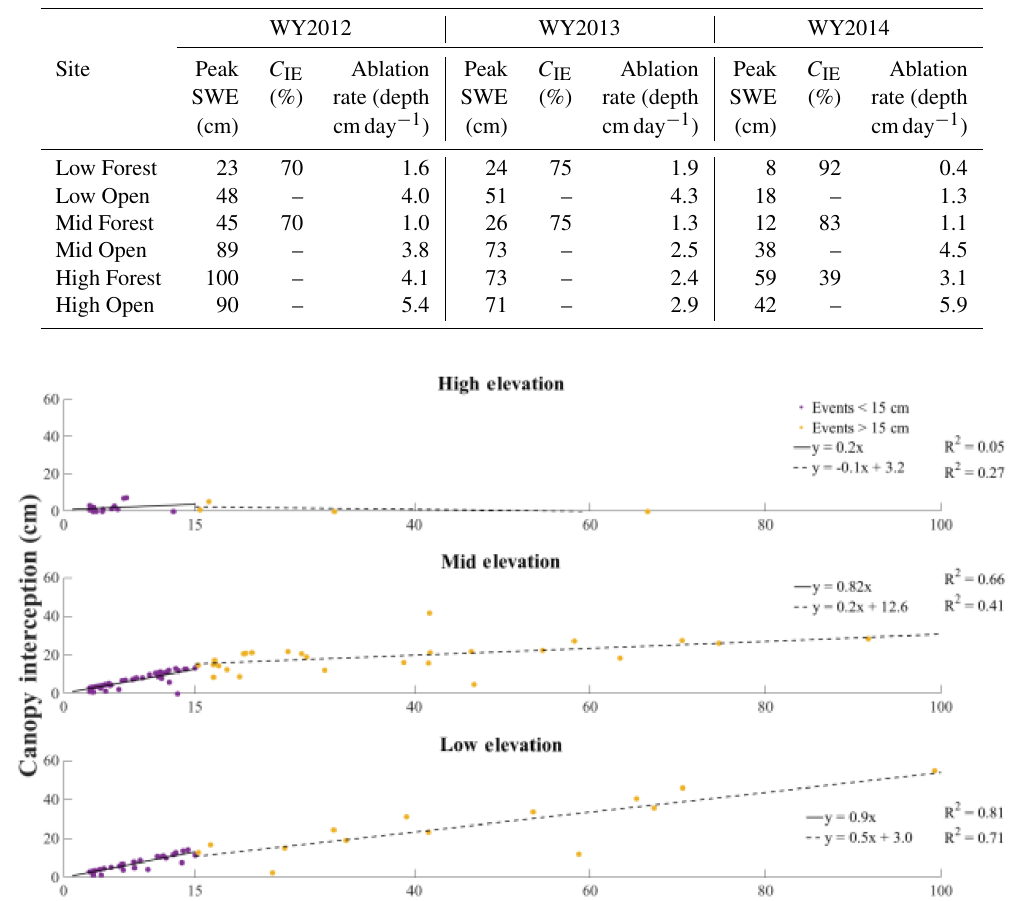
Table 2. Summary snow statistics for WY 2012–WY 2014 – Oregon ForEST network.